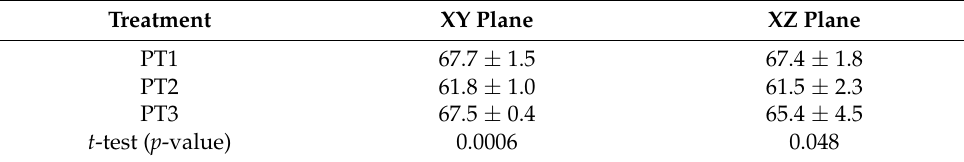
Table 2. Hardness values of specimens after the PT1, PT2, and PT3 treatments.